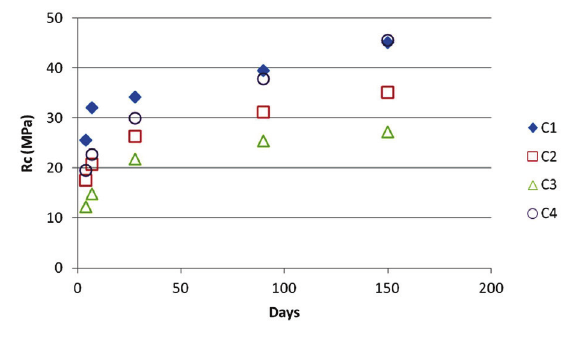
Fig. 4. Strength gain of C1, C2, C3 and C4 concrete mixtures